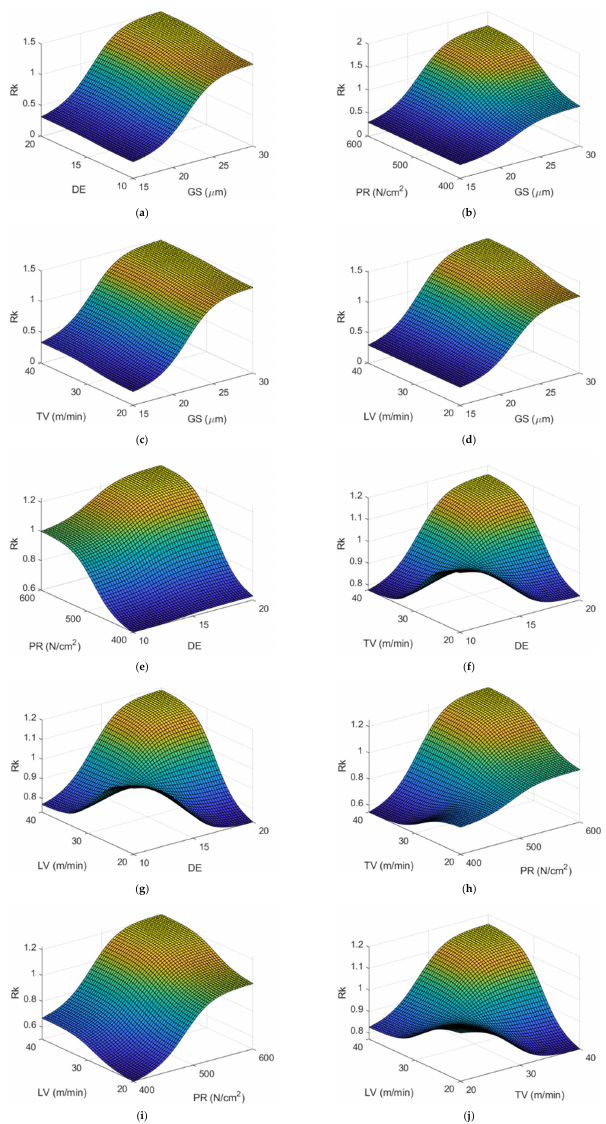
Figure 7. Response surface for (Rk (µm)) versus each pair of input variables while the rest are kept at their central values, using the ANFIS developed for (Rk): ( a ) GS and DE; ( b ) GS and PR; ( c ) GS and TV; ( d ) GS and LV; ( e ) DE and PR; ( f ) DE and TV; ( g ) DE and LV; ( h ) PR and TV; ( i ) PR and LV; ( j ) TV and LV.